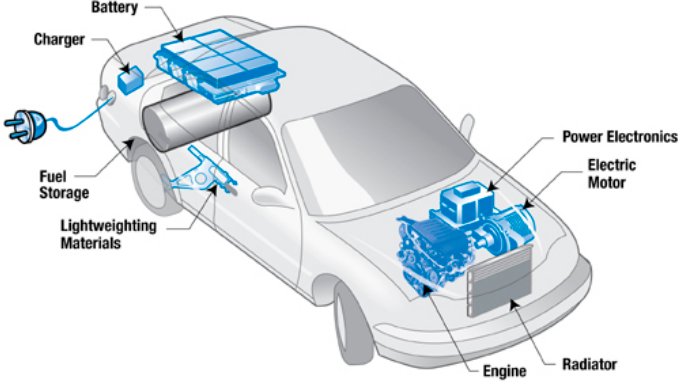
Figure 3. Main components in a typical hybrid electric vehicle (HEV).